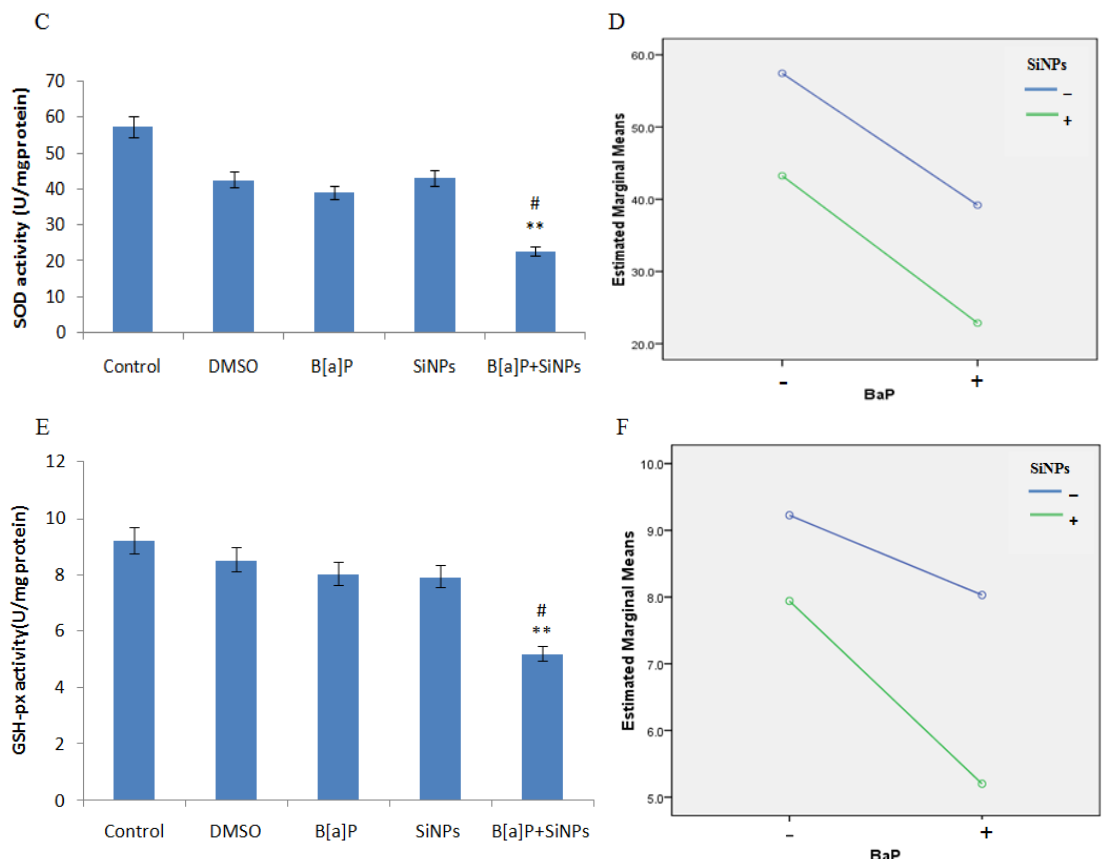
Figure 5. HUVEC oxidative stress caused by SiNPs and B[a]P co-exposure. ( A ) Malondialdehyde content increased; ( B ) Profile plots shows that SiNPs and B[a]P synergistically increased the malondialdehyde content ( F = 5.084, p = 0.026); ( C ) Decreased superoxide dismutase activity; ( D ) Profile plots shows that the superoxide dismutase activity decrease was additive ( F = 3.506, p = 0.143); ( E ) Decrease in glutathione peroxidase activity; ( F ) Profile plot shows a synergy interaction in the decrease of glutathione peroxidase activity ( F = 11.174, p = 0.006). ** p < 0.01 for the treated group compared to the control, while # p < 0.05 for the combined group compared to single treated groups.